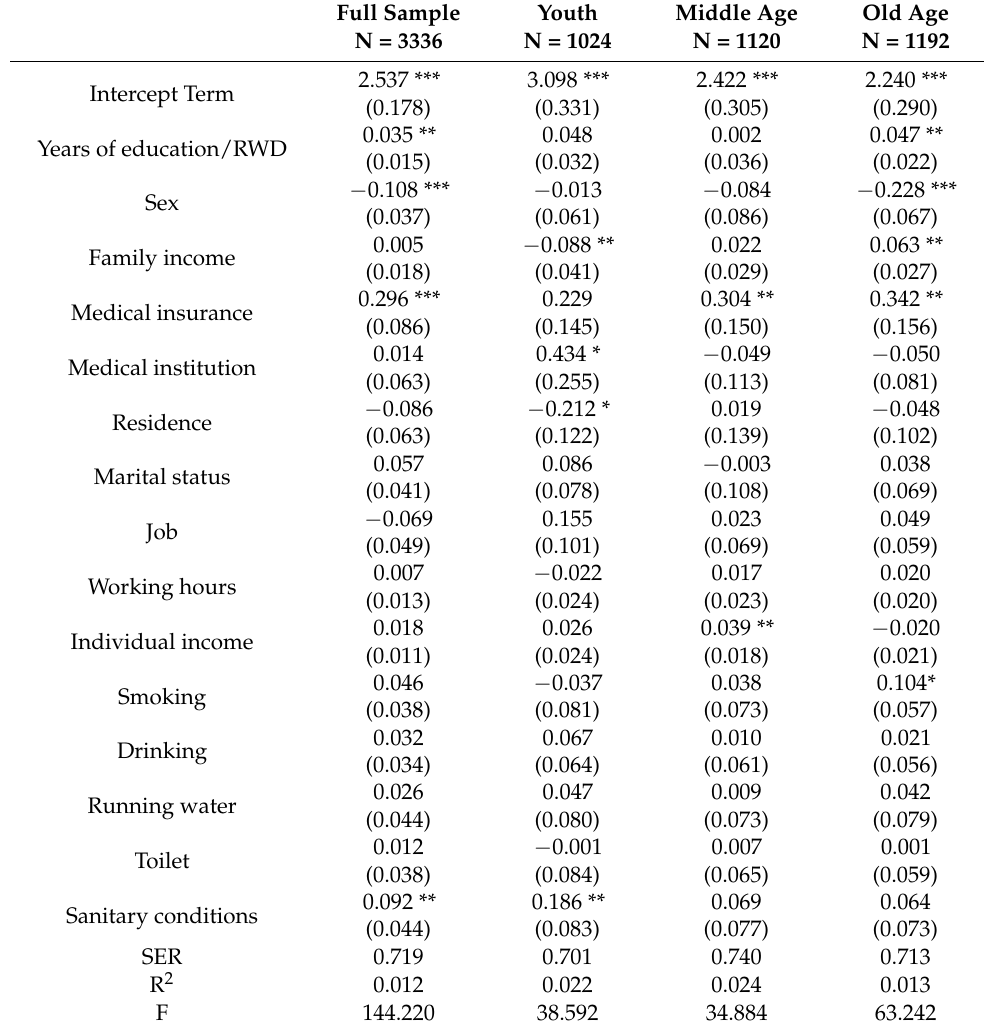
Table 6. Results of two- stage least squares (by age, for psychological